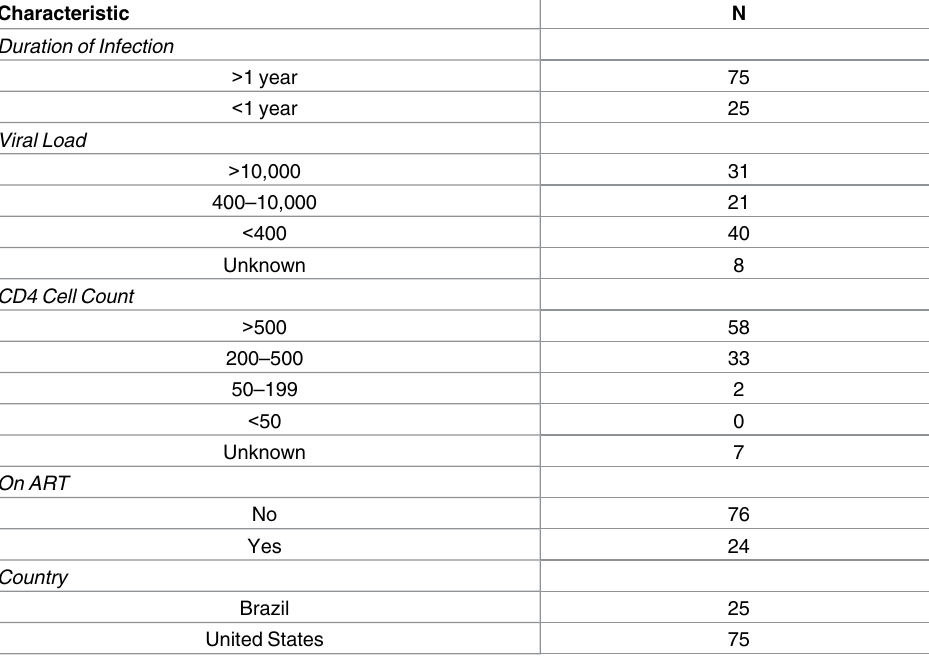
Table 1. Characteristics of matched plasma and DBS